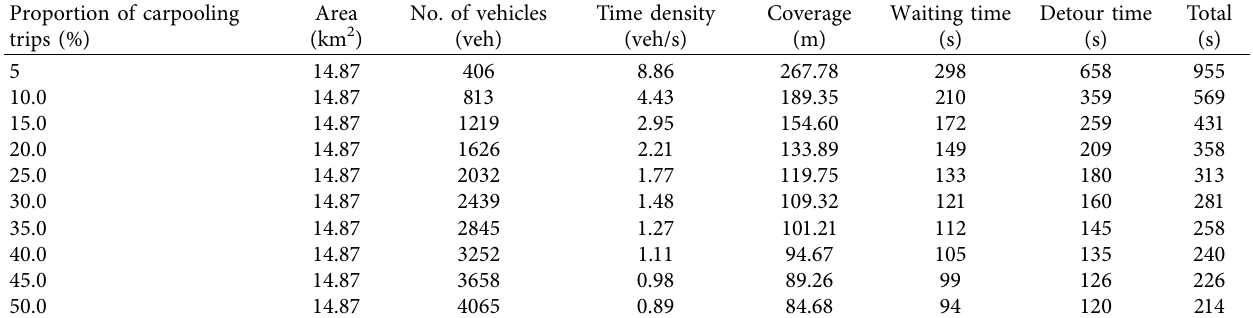
Table 10: Travel time and detour time for different proportions of carpool trips.